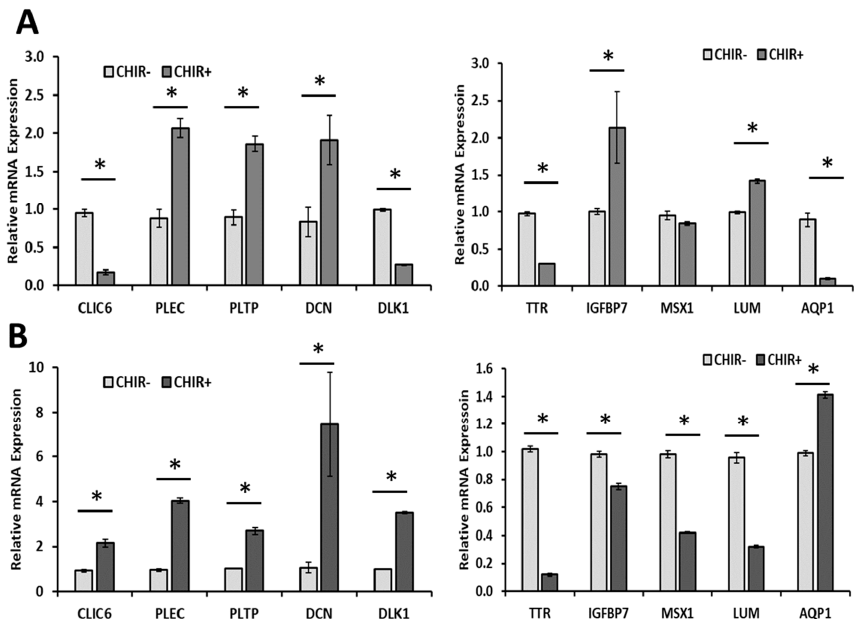
Figure 3. mRNA expression of ChP markers at days 18 and 30 for CHIR+/ − conditions. mRNA expression was determined by RT-qPCR. ( A ) Day 18; ( B ) day 30 of differentiation. N = 3. * indicates p < 0.05. CHIR(+/ − ) indicates treatment with CHIR99021.